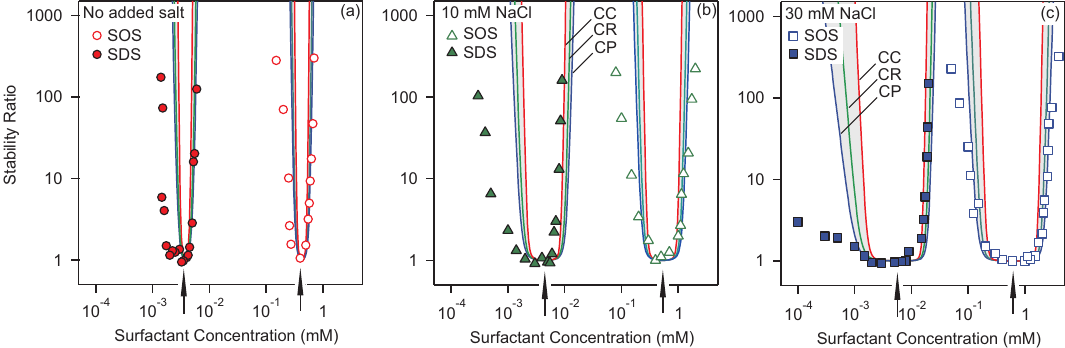
Figure 5. Stability ratios for homoaggregation of AL particles in the presence of SOS and SDS with ( a ) no added NaCl, ( b ) 10 mM NaCl, and ( c ) 30 mM NaCl added. Symbols represent experimental data, while lines show calculations based on DLVO theory. CC, CR, and CP labels mark constant charge, constant regulation, and constant potential boundary conditions. For the CR model the regulation parameters for both particles are equal to 0.5. The IEPs are indicated with